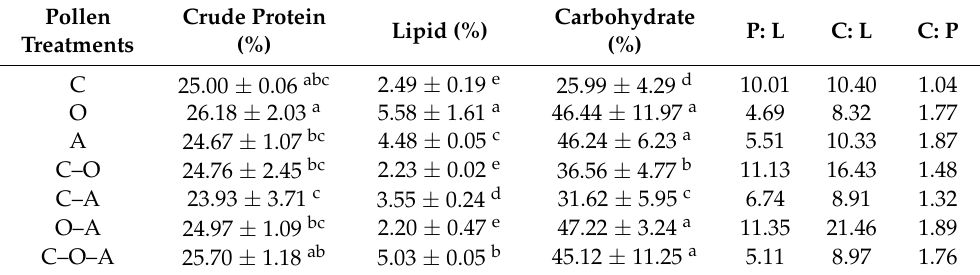
Table 2. Major nutrients and proportions of the pollen